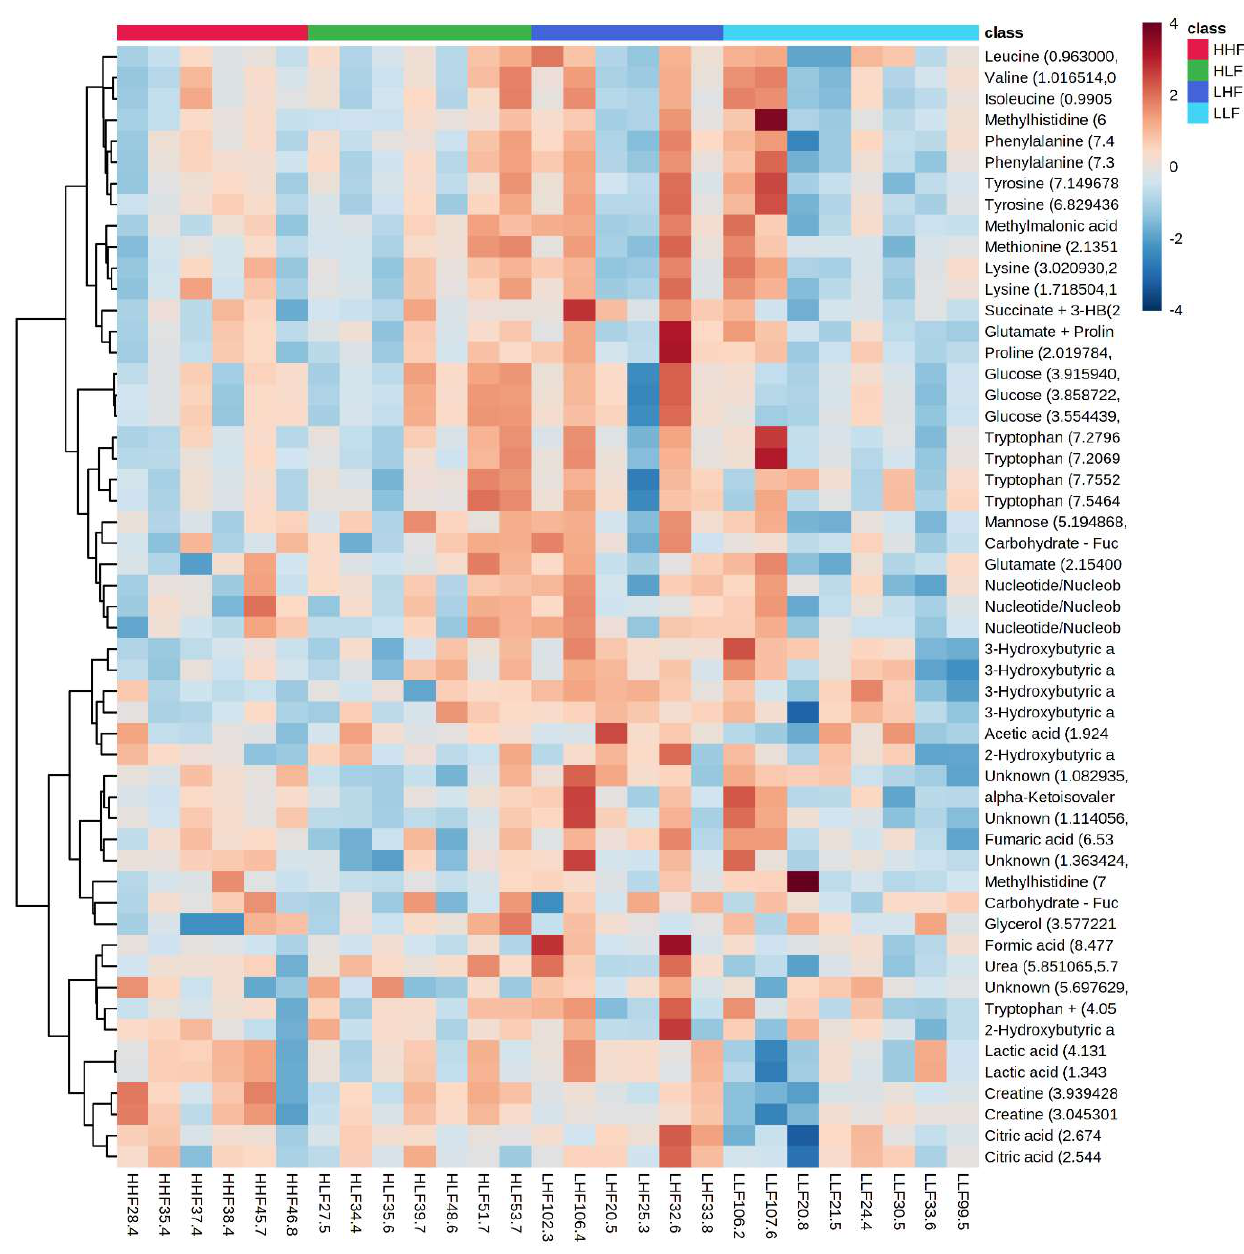
Figure 3. Heatmaps and dendrograms of metabolites in offspring exposed to high maternal and high postnatal LA diets in females (HHF: red), high maternal and low postnatal LA diets in females (HLF: green), low maternal and high postnatal LA diets in females (LHF: dark blue), and low maternal and low postnatal LA diets in females (LLF: light blue). Offspring numbers are indicated on the bottom axis of the graph, whilst the top axis indicates their corresponding group colors. All metabolites have been logarithmically scaled. Heatmap scales are denoted by red being higher concentrations, blue being lower, with white residing in the middle. Pearson clustering algorithm used for dendrograms to indicate relationships between metabolites in the cohort.